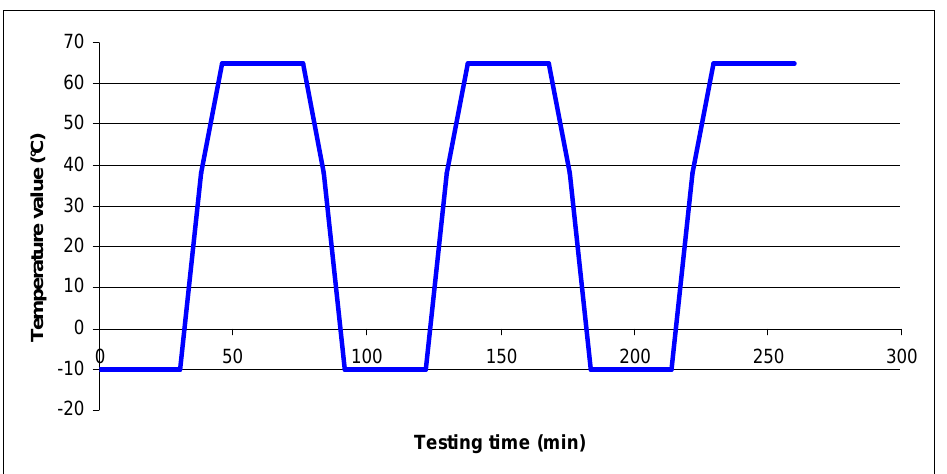
Figure 2. Example of ESS testing program.